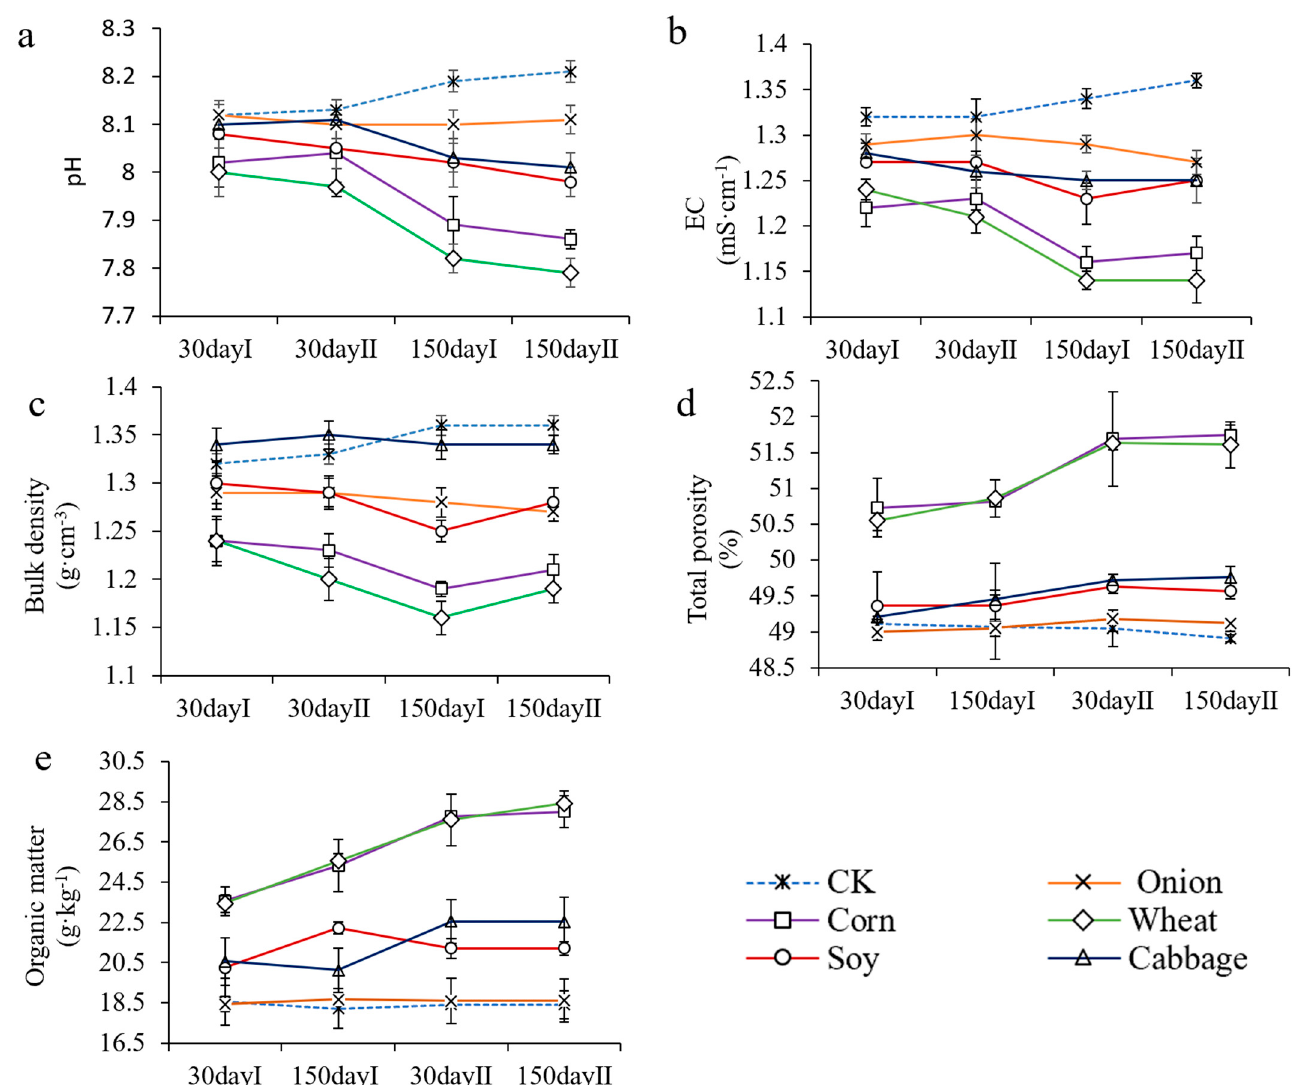
Figure 1. Effects of different catch crops on soil physical and chemical characters. pH ( a ), EC ( b ), Bulk density ( c ), Total porosity ( d ), Organic matter ( e ). CK–blank control with no catch crop.